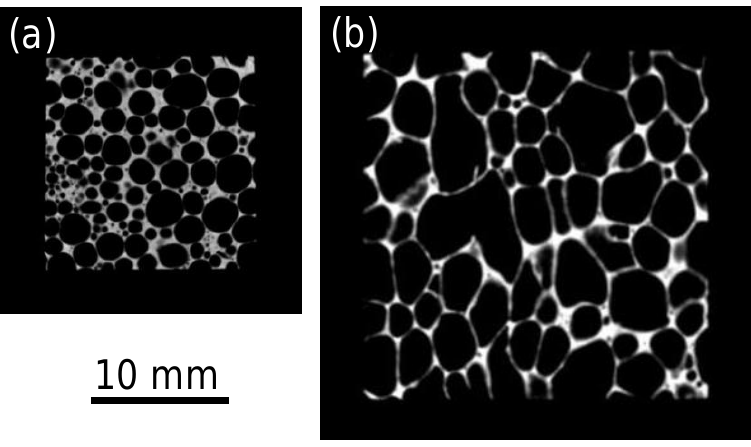
Figure 2. ( a ) Relative frequency of pore area A for ADC12 foams and ALPORAS; ( b ) Relationship between porosity p of the foams and average pore diameter d